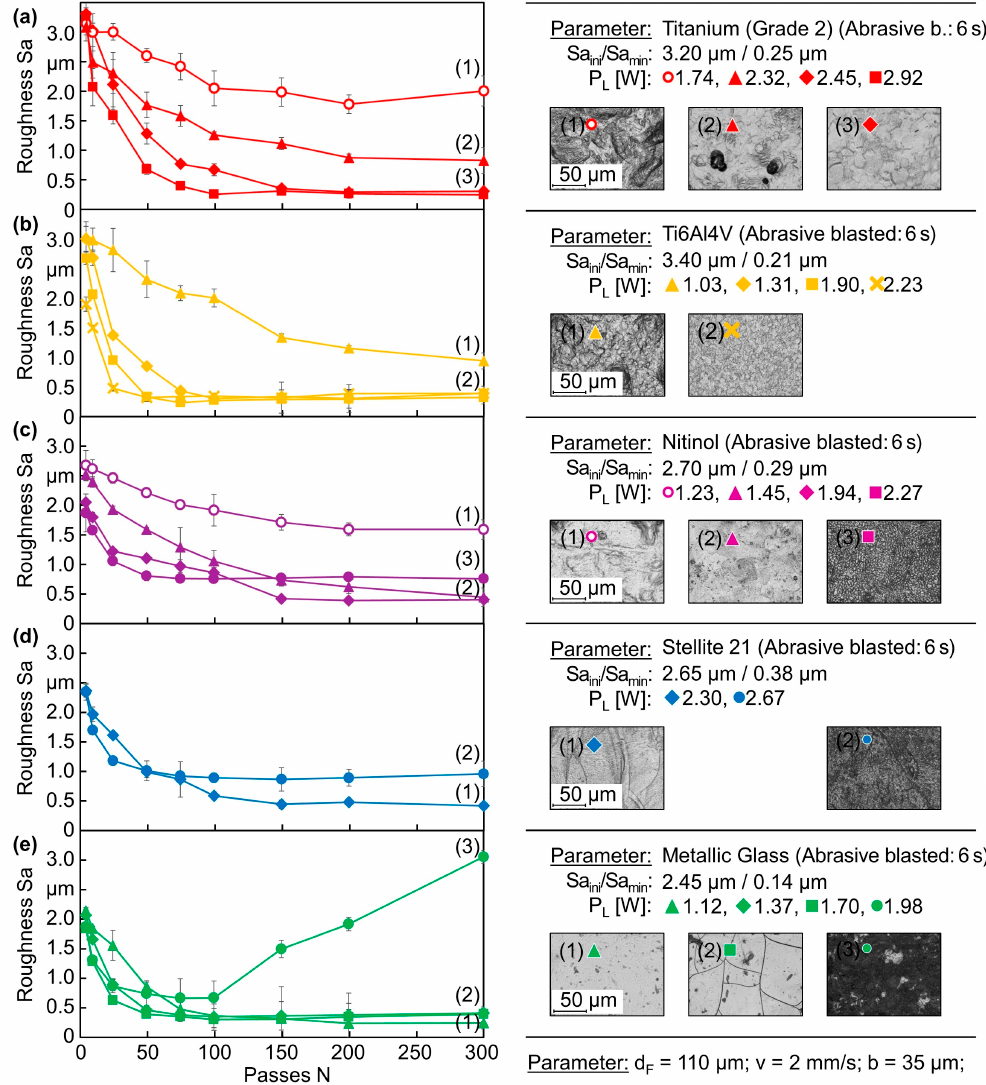
Figure 9. The ( left side ) shows from ( a – e ) the roughness over the number of passes for different materials, and on the ( right side ) the corresponding parameter settings including microscope images.